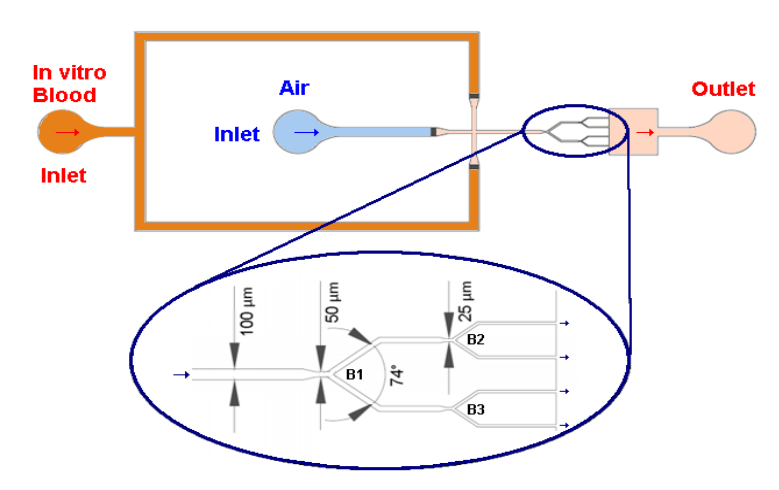
Figure 1. Schematic diagram of the microfluidic system and main dimensions of the network micro- channel used in this study: B1 is the first level bifurcation and B2 and B3 are second level bifurcations.